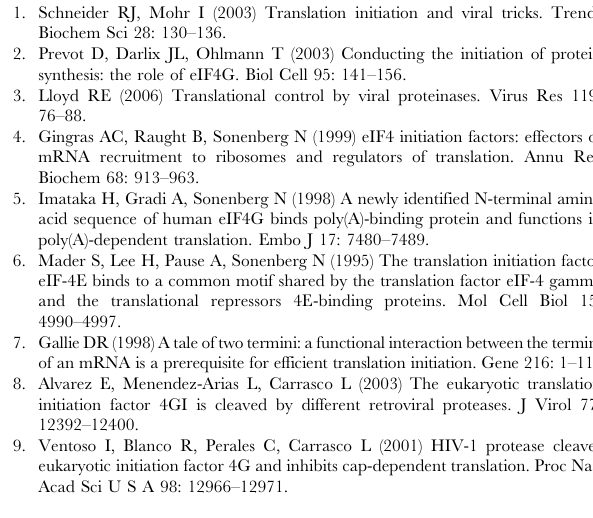
Figure S2 Translation of exogenous and endogenous luc mRNAs in HIV-1 PR treated Kreb-2 extracts. Non-nuclease- treated Kreb-2 extracts supplemented with [35S]Met-[35S]Cys/ ml were programmed with 50 ng of ( + / 2 ) or ( + / + ) luc mRNAs. After 8 min, 20 ng of HIV-1 PR were added to the lysates. The samples were analyzed 1 and 3 h after the initiation of the reaction. A) Luc activity at each time point was measured and plotted. Error bars indicate standard deviations obtained from three measurements of each sample. B) Relative quantification of the Luc activity obtained from HeLa extracts programmed with ( + / 2 ) or ( + / + ) mRNAs in presence of HIV-1 PR with respect to control extracts after 1 h of incubation. SDs were obtained from three independent experiments. C) eIF4GI, eIF4GII and PABP were detected by western blot. D) Endogenous protein synthesis was analyzed by SDS-PAGE followed by fluorography and